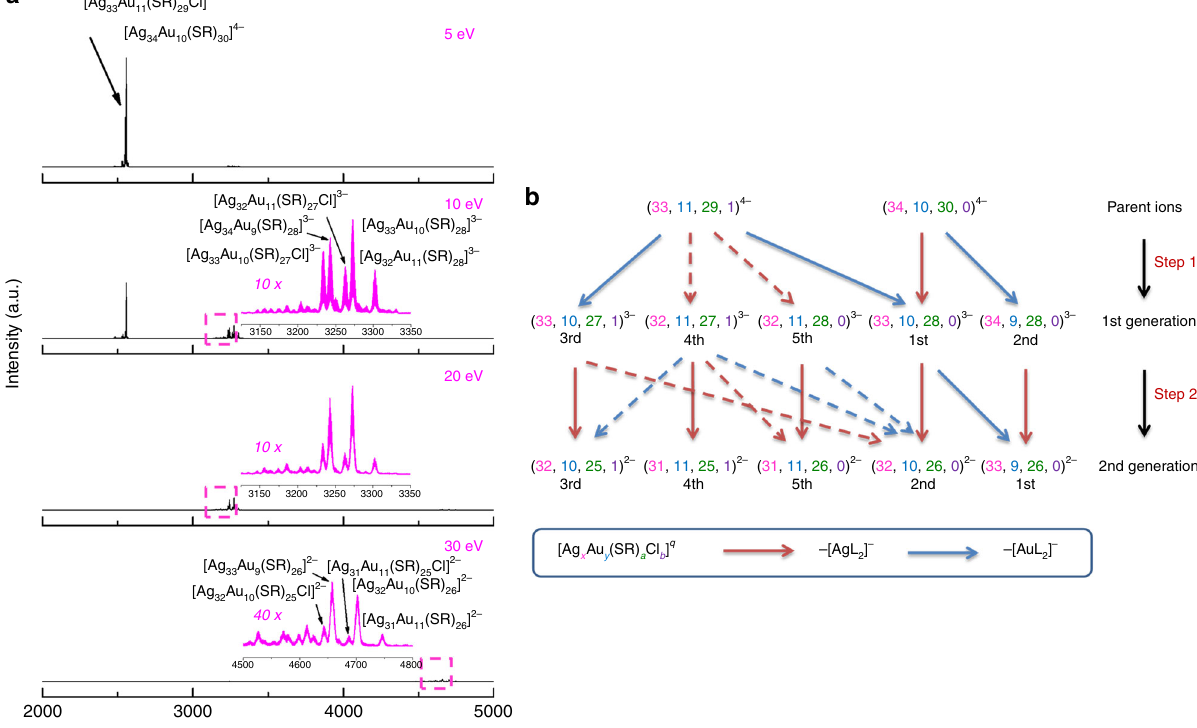
Fig. 3 Fragmentation habit of Ag@Au nanoclusters. a Tandem mass spectra and b schematic illustration of fragmentation process of Ag-core/Au-shell [Ag 34 Au 10 L 30 ] 4 − and [Ag 33 Au 11 L 30 ] 4 − (marginal) ions (centered at m/z = 2558) obtained at different collision energies. The ligand (L) is thiolate (SR) or halogen (e.g., Cl), and [Ag x Au y (SR) a Cl b ] q nanoclusters are referred to as ( x , y , a , b ) q for simplicity. Insets of a are zoom-in spectra of the boxed area in the corresponding panels. The purple and blue arrows in b indicate fragmentation pathways by dissociation of [AgL 2 ] − and [AuL 2 ] − , respectively; while the solid and dotted arrows show dominant and minor fragmentation pathways, respectively. The abundance sequence of each fragment cluster ion is indicated underneath in